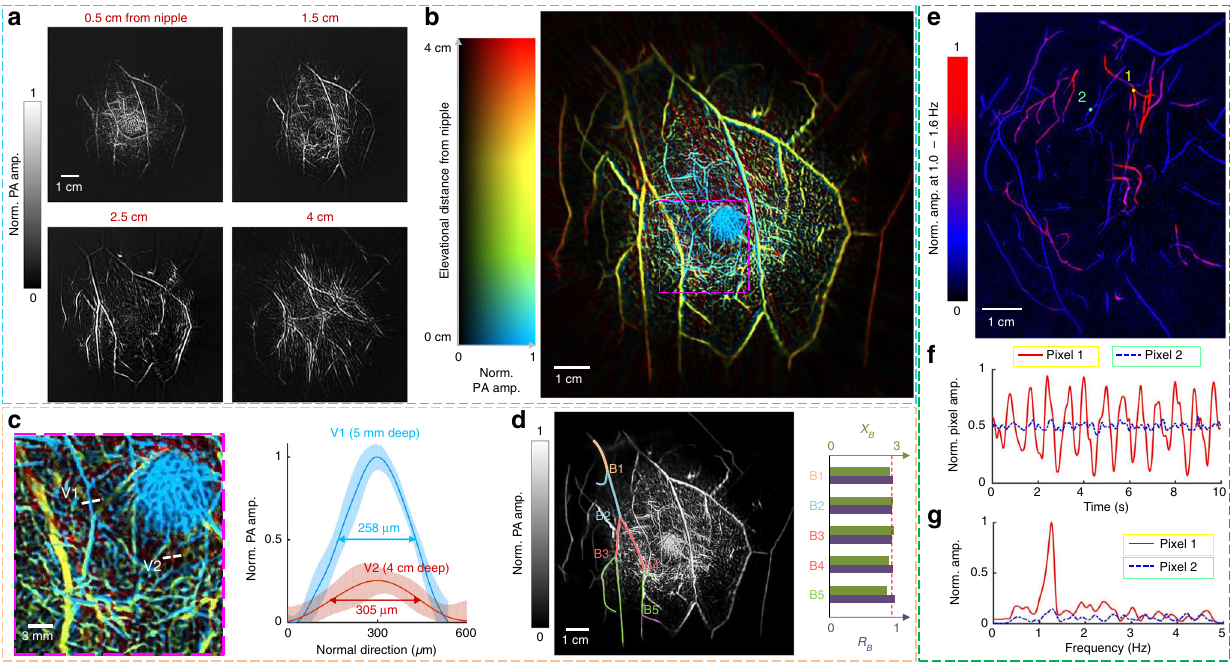
Fig. 2 SBH-PACT of healthy breasts. a Vasculature in the right breast of a 27-year-old healthy female volunteer. Images at four depths are shown in increasing depth order from the nipple to the chest wall (also see Supplementary Movie 2). b The same breast image with color-encoded depths. c A close- up view of the region outlined by the magenta dashed box in b , with selected thin vessels and their line spread plots. d A selected vessel tree with fi ve vessel bifurcations, labeled from B1 to B5. At each bifurcation, the diameter relationships between the parent vessel ( D parent ) and daughter vessels ( D daughter ) are presented on the right. X B is the junction exponent, and R B is de fi ned as R B ¼ D 3 network mapping of a breast cross-sectional image (red = artery, blue = vein). f Amplitude fl uctuation in the time domain of the two pixels highlighted by yellow and green dots in e . The pixel value in the artery shows changes associated with arterial pulse propagation (also see Supplementary Movie 3). g Fourier domain of the pixel value fl uctuations in f . The oscillation of the arterial pixel value shows the heartbeat frequency at ~1.2